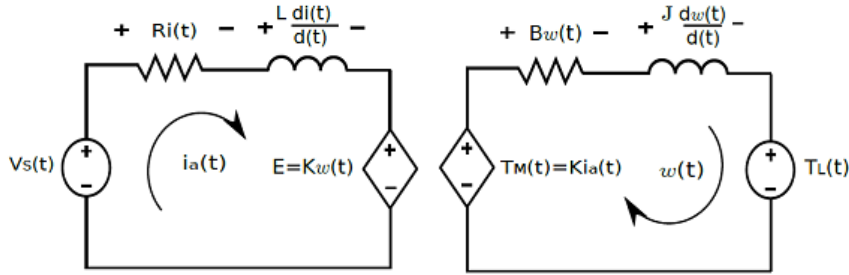
Figure 3. Equivalent circuit of a DC motor. Pure electrical circuit with 2 meshes.